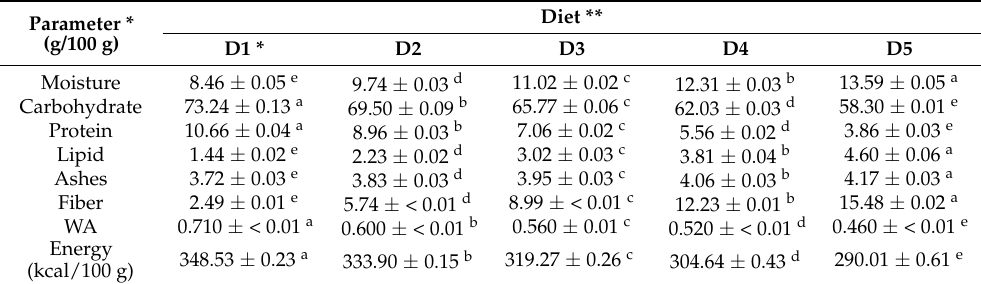
Table 1. Macronutrient composition, water activity, and energy value of diets with and without grape residue for Zophobas atratus larvae